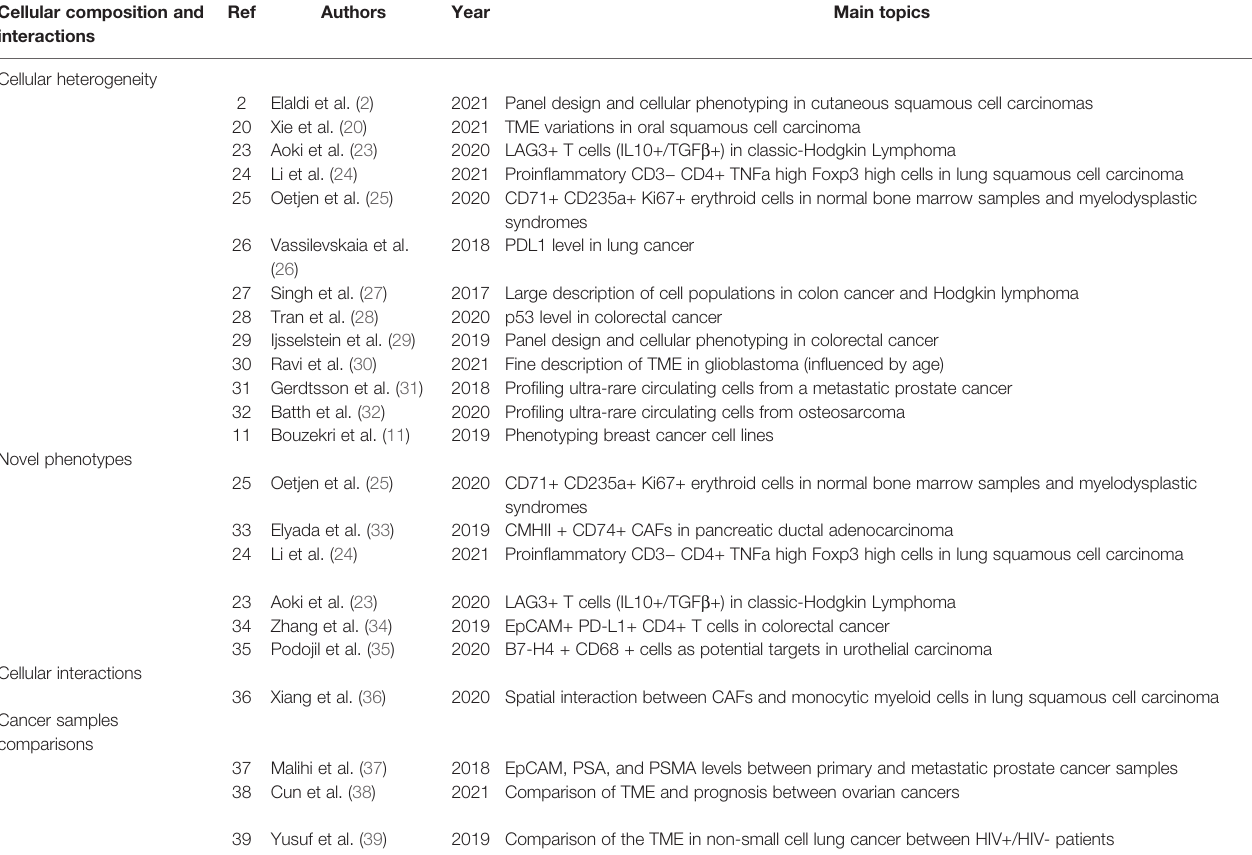
TABLE 1 | Summary table of studies using IMC technology for the description of the cellular composition and their interaction in cancer tissue. Cellular composition and